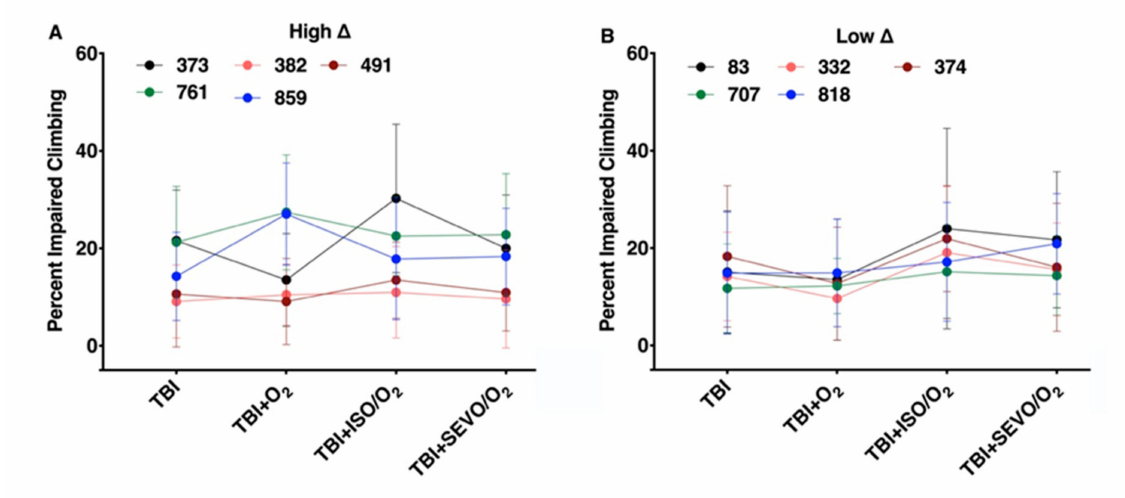
Figure 7. Locomotion response of individual of RAL lines. The e ff ect of treatments on climbing performance were more heterogenous in the ( A ) high ∆ group than the ( B ) low ∆ group.